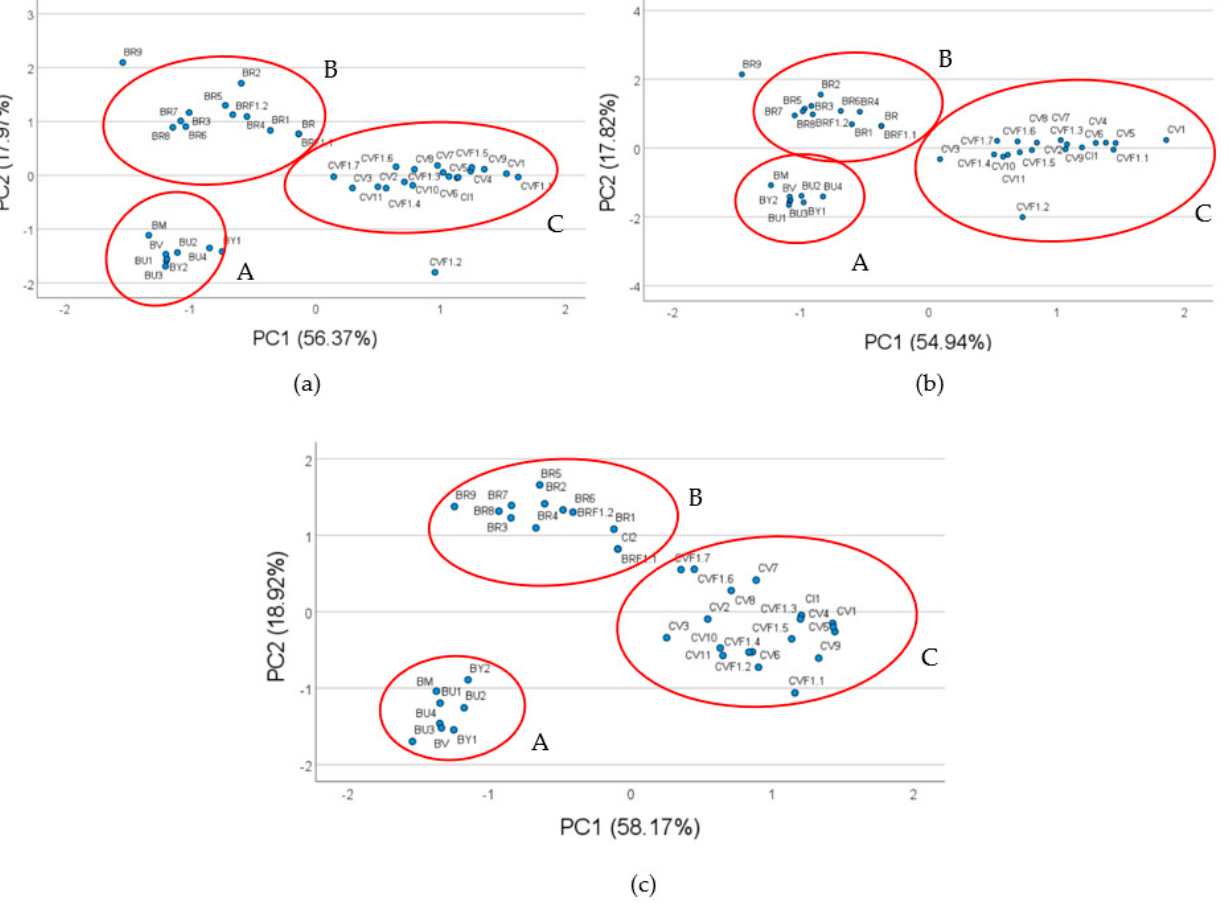
Figure 2. PCA plots performed utilizing three of the most correlated alleles with the inflorescence traits: allele of 155 bp for P1 ( a ), allele of 165 bp for P2 ( b ), allele of 288 bp for P4 ( c ), respectively.